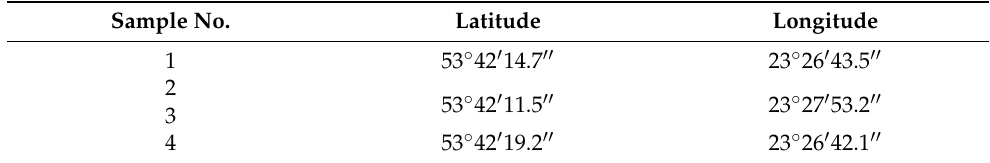
Table 1. Sample point locations in the WGS84